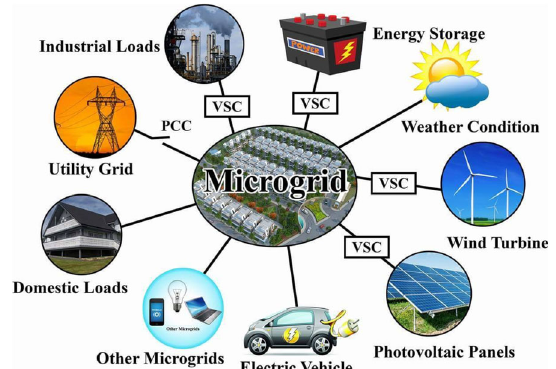
Fig. 11 An Illustration of Islanded Microgrid